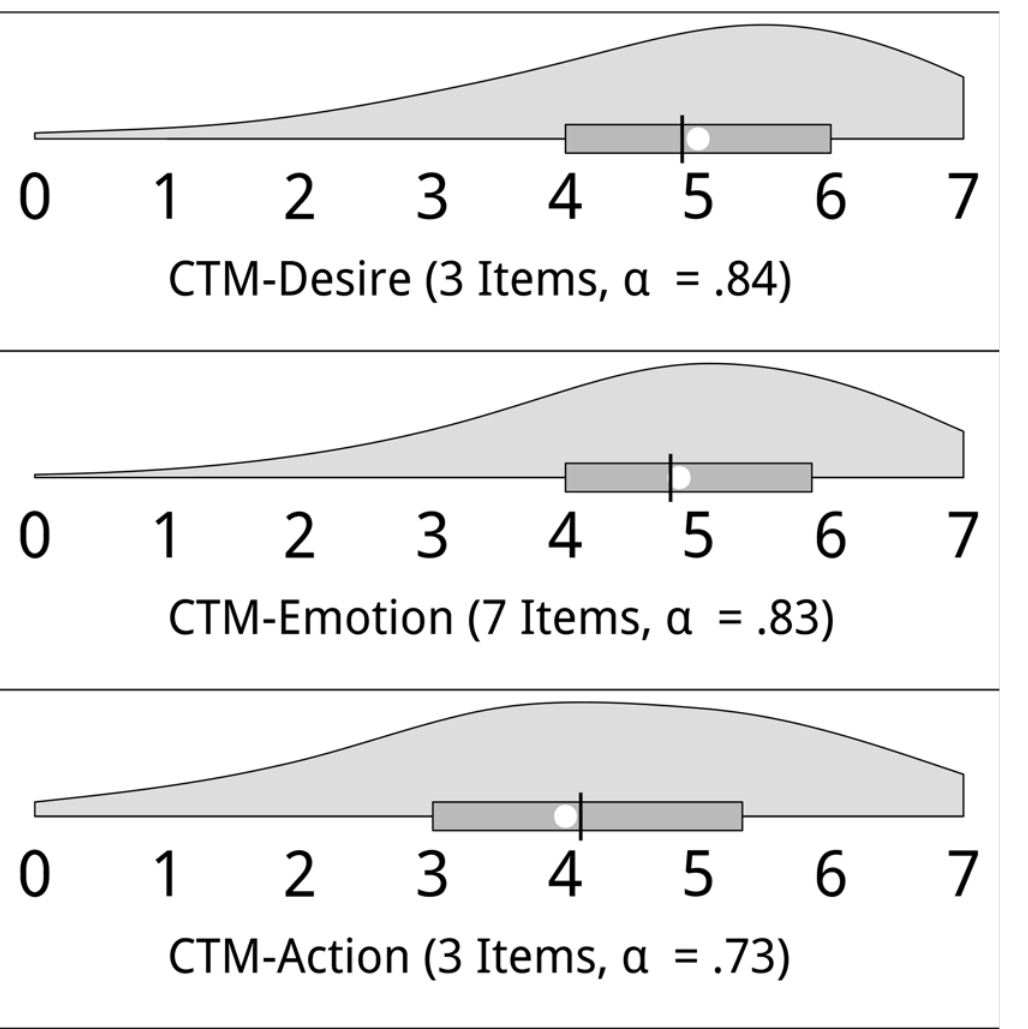
Fig 2. Distribution of the scale values (violin plots) of the desire, emotion and action subscales of the culture-transmission motive (CTM) measure. Higher values reflect a stronger culture-transmission motive. The white circle represents the median and the black bar the mean; the box ranges from the first to the third quartile. Answer scales were item-specific (see